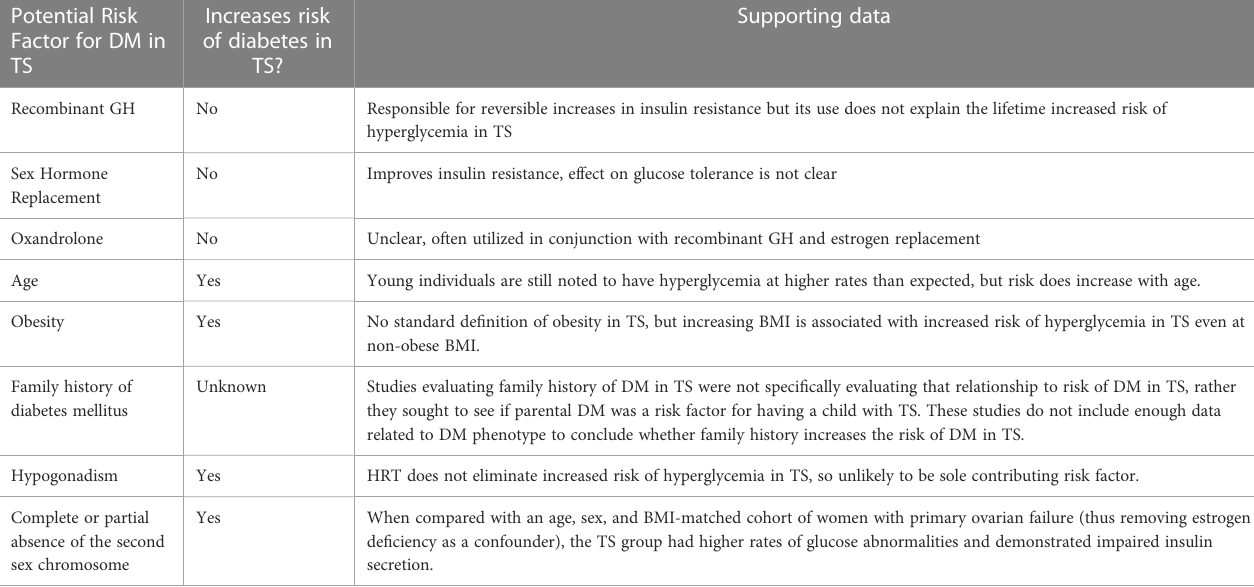
TABLE 1 Summary of therapeutic, clinical, and genetic factors thought to be related to increased risk of hyperglycemia in TS. Potential Risk Factor for DM in